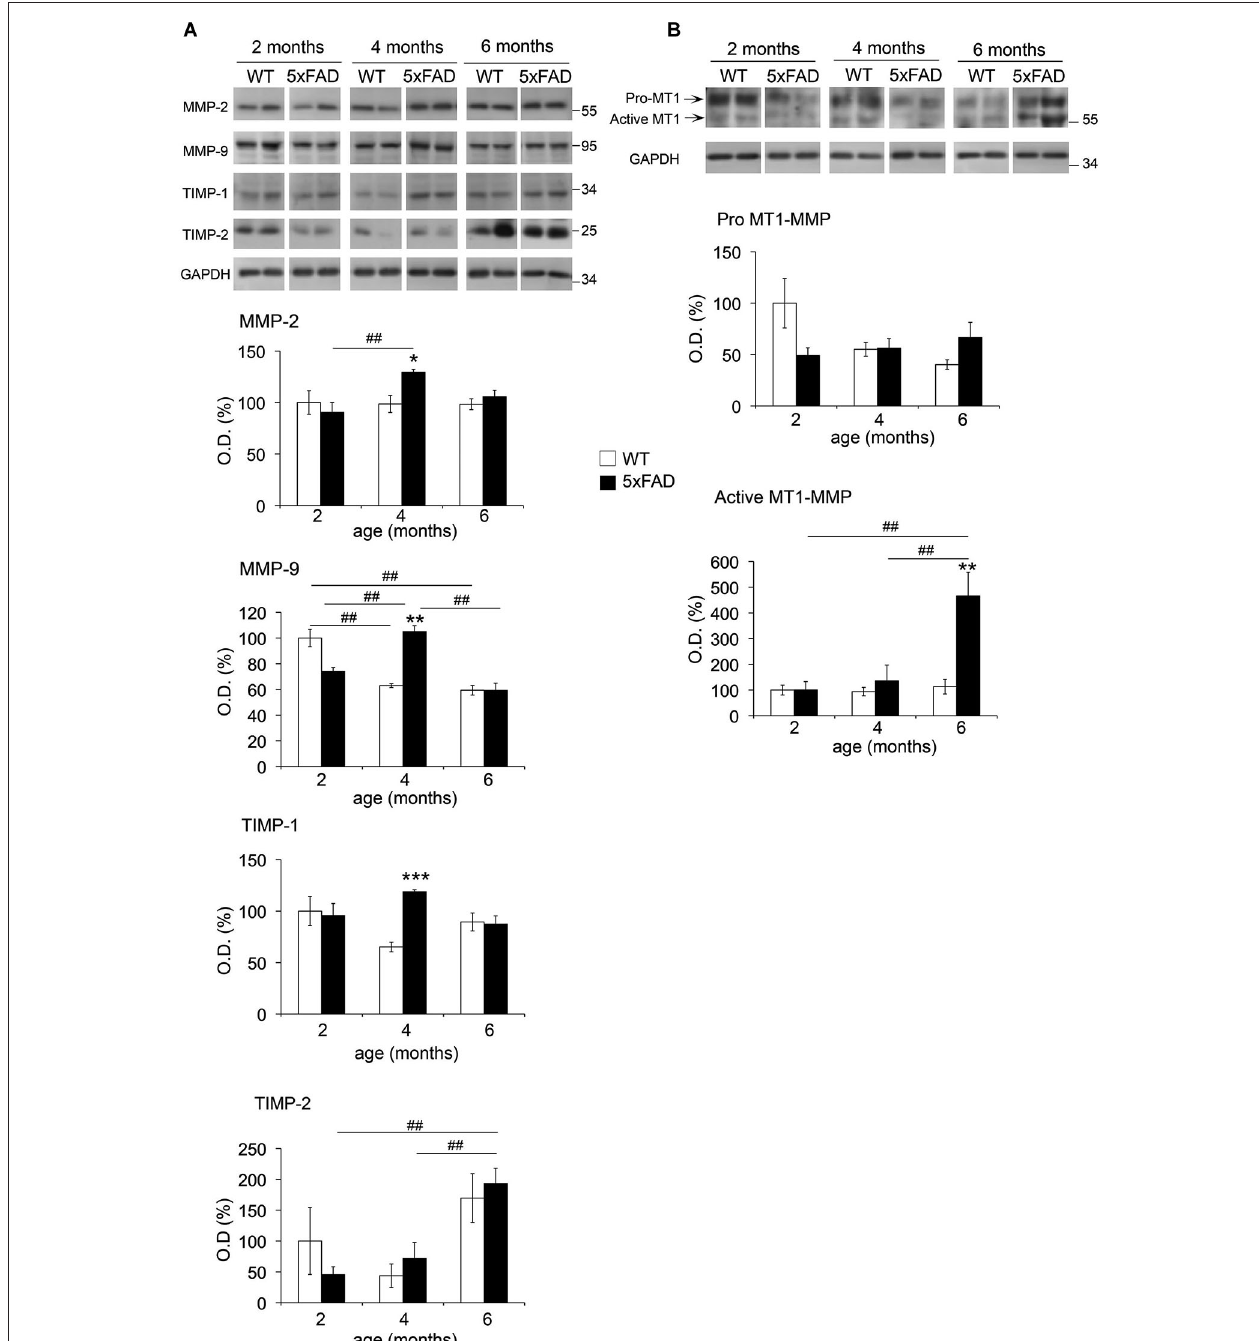
GAPDH normalized values are the mean ± SEM of four mice per group representing the percentage of variation in optical density (O.D.). * p < 0.05, ** p < 0.01, *** p < 0.001 when comparing 5xFAD vs . WT of the same age; # p < 0.05, ## p < 0.01, ### p < 0.001 when comparing the same genotype across age; ANOVA followed by Tukey’s